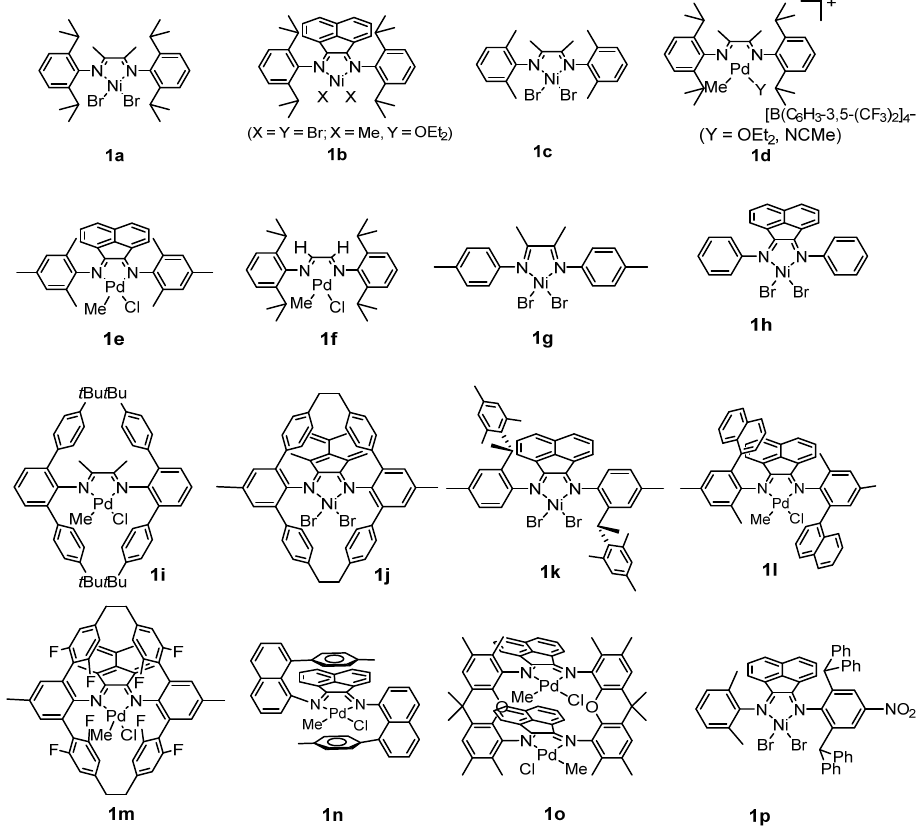
Figure 3. Crystallographic structure of NiBr 2 ( L1 )·(C 2 H 4 Cl 2 ). Selected bond distances (Å) and